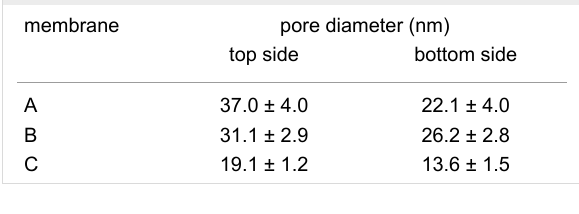
Table 1: Pore sizes from top view HRSEM images of the analyzed membranes A, B, and C. membrane